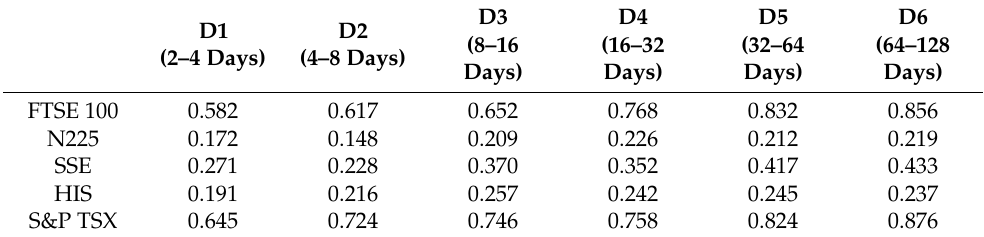
Table 4. WC-GARCH-GJR (1,1) estimation results during the COVID-19